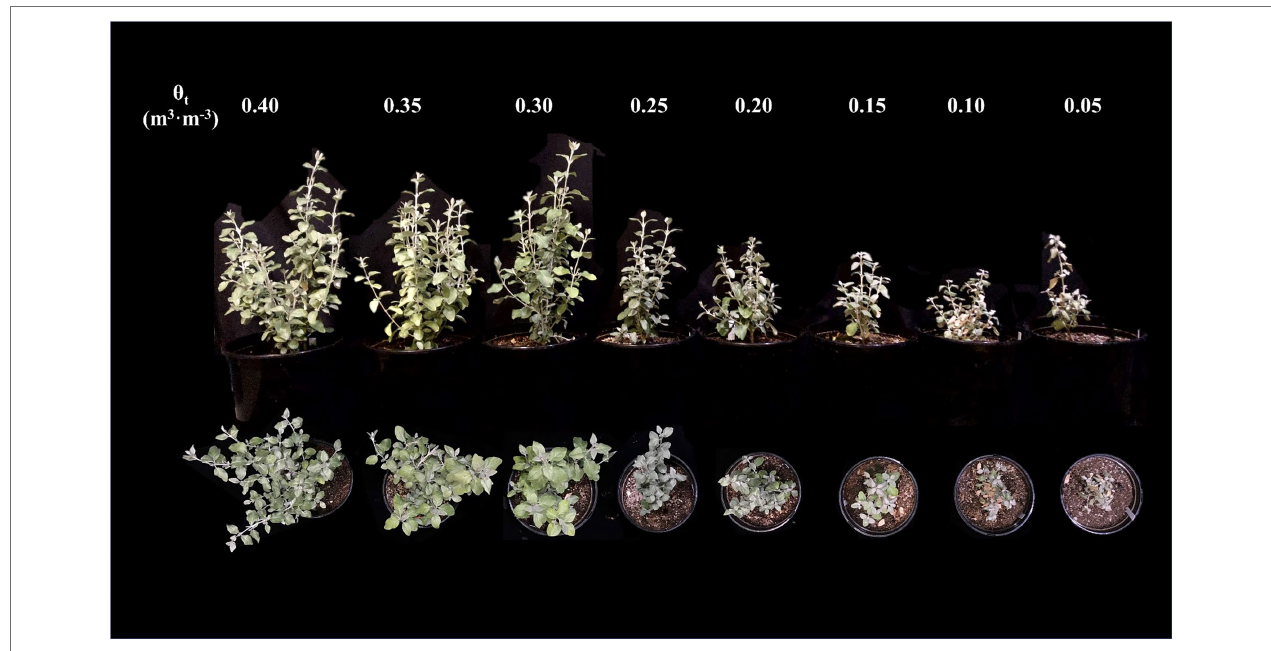
FIGURE 3 | Shepherdia ×utahensis plants at eight substrate volumetric water content treatments ( θ t ) at the end of the experiment (photo taken on 10 January 2021).